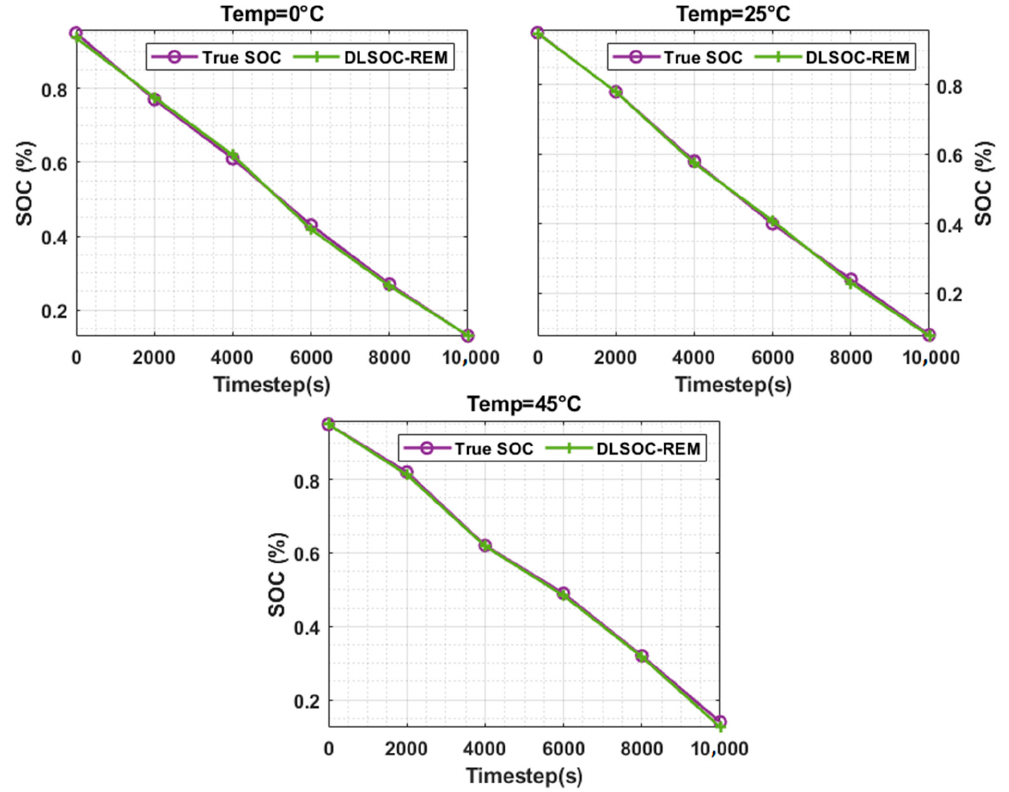
Figure 9. SOC analysis of DLSOC-REM technique on FUDS drive cycle.